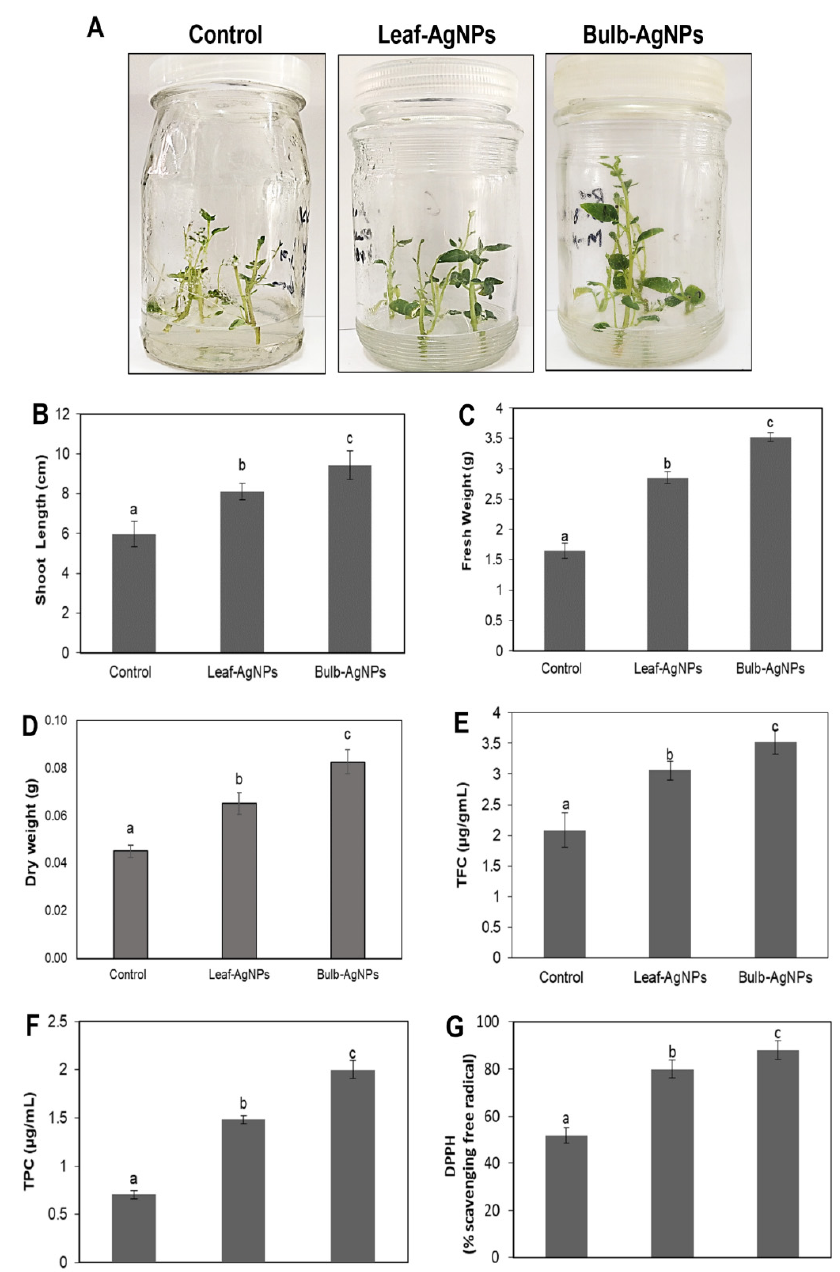
Figure 10. Effects of leaf-AgNPs and bulb-AgNPs regarding the in vitro micropropagation, growth response, and biomass production of Solanum tuberosum L. plantlets grown under a controlled environment. ( A ) Comparison of plant height, ( B ) shoot length, ( C ) fresh weight, ( D ) dry weight, ( E ) total flavonoid content, ( F ) total phenolic content, and ( G ) DPPH (% free radical scavenging activity) at 30 DAC. Values are the mean ± standard error from three replicates. Different letters indicate a significant difference ( p < 0.05) in values between control and treated plantlets.